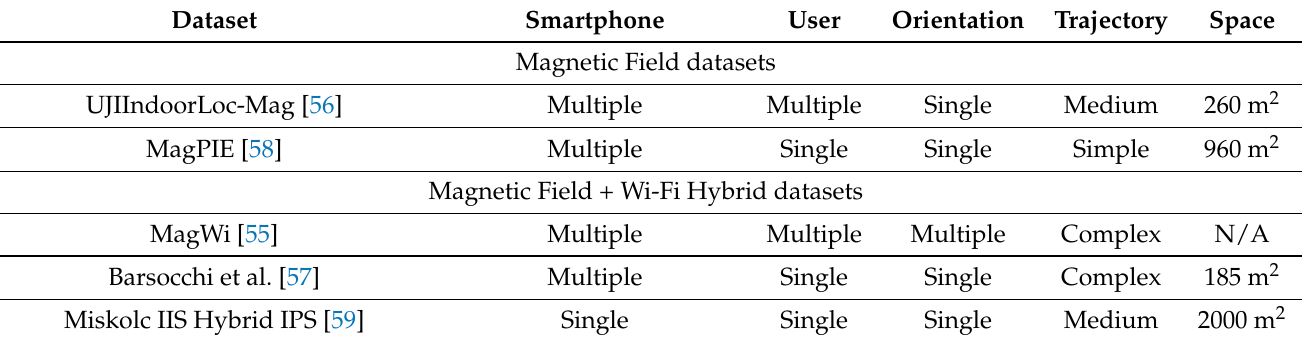
Table 2. Overview of existing publicly available